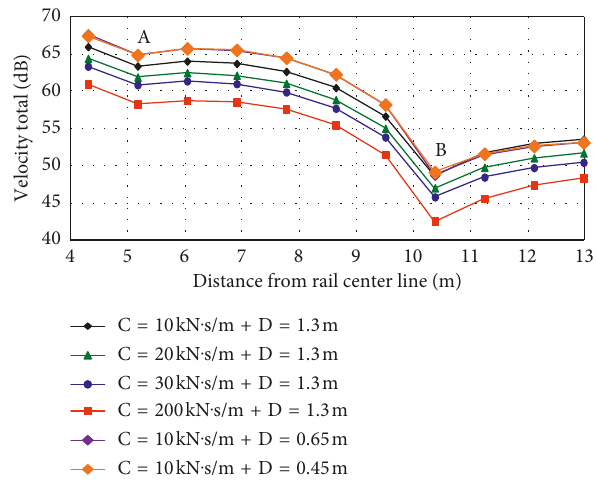
Figure 8: Finite element results for the vibration total dB (equation (8)) changing with the distance from the rail centerline under a rail pad stiffness of 1E4kN/m (where C is the rail pad damping and D is the interval of the rail pad).